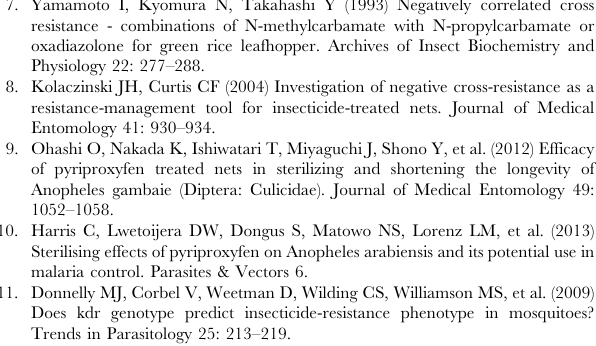
Figure S1 Flow chart of mosquito life cycle based on the diagram from Le Menach et al [7] and Griffin et al [6]. Figure S2 Flow chart depicting the life history and expected number of oviposited eggs of a pyrethroid-resistant mosquito. M n denotes a mosquito having completed n gonotrophic cycles. M PPF, n denotes a mosquito that has completed n gonotrophic cycles and also been exposed to PPF. p PPF is the probability that a mosquito contacts PPF at each feeding attempt. q PPF = 1 - p PPF is the probability that a mosquito avoids contact with PPF during a feeding attempt. Figure S3 Comparison of the reproductive fitness of pyrethroid- susceptible and pyrethroid-resistant mosquitoes in the presence of co-treated pyrethroid/PPF nets at 30% and 80% coverage. Reduction in fecundity is defined as the proportional reduction in the number of eggs per oviposition. Red regions of parameter space represent scenarios where more eggs are oviposited by pyrethroid-resistant mosquitoes than pyrethroid-susceptible mos- quitoes. Green regions of parameter space represent scenarios where more eggs are oviposited by pyrethroid-susceptible mosquitoes than pyrethroid- resistant mosquitoes. Yellow regions of parameter space represent scenarios where approximately the same number of eggs is oviposited by pyrethroid-susceptible mosquitoes and pyrethroid- resistant mosquitoes. Reductions in fecundity and life expectancy observed by different concentration of PPF on bed nets by Ohashi et al [11] are represented as points.